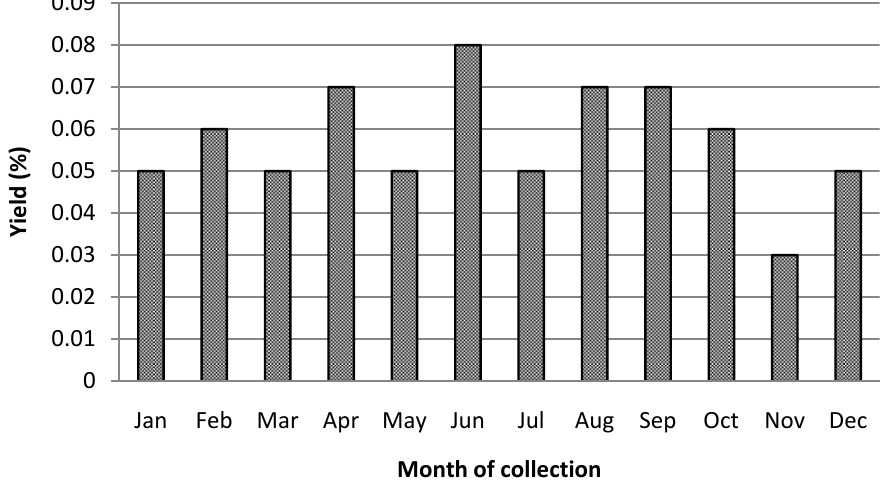
Figure 2. Monthly extraction yields of the essential oils from the leaves of Porcelia macrocarpa